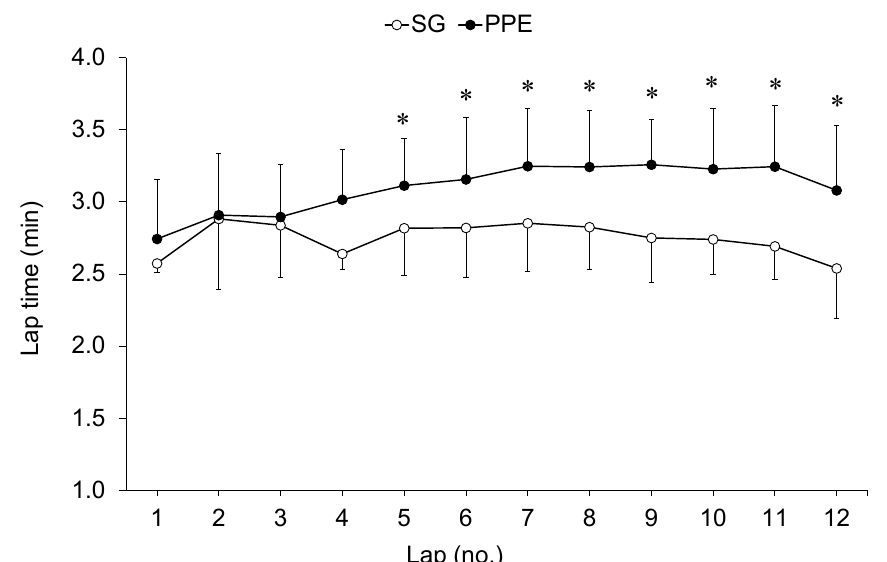
Figure 1. Lap time during the Pack Test performed wearing traditional short sports gear (SG) and wildland firefighters’ personal protective equipment (PPE). Values are mean ± SD. * indicates significant difference ( p < 0.05).